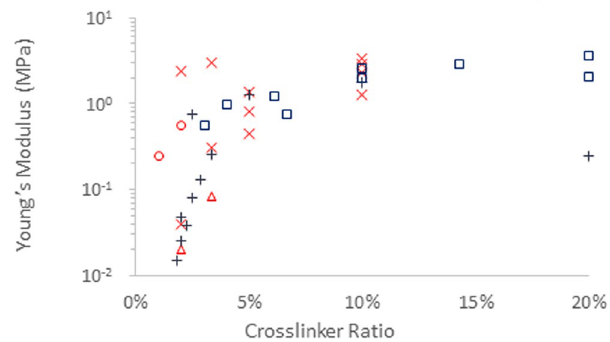
Figure 1. Young’s modulus of Sylgard 184 PDMS samples with varying base/crosslinker ratios highlighting the discrepancies between different testing methods, particularly at low levels of crosslinking (softer samples) 11–18